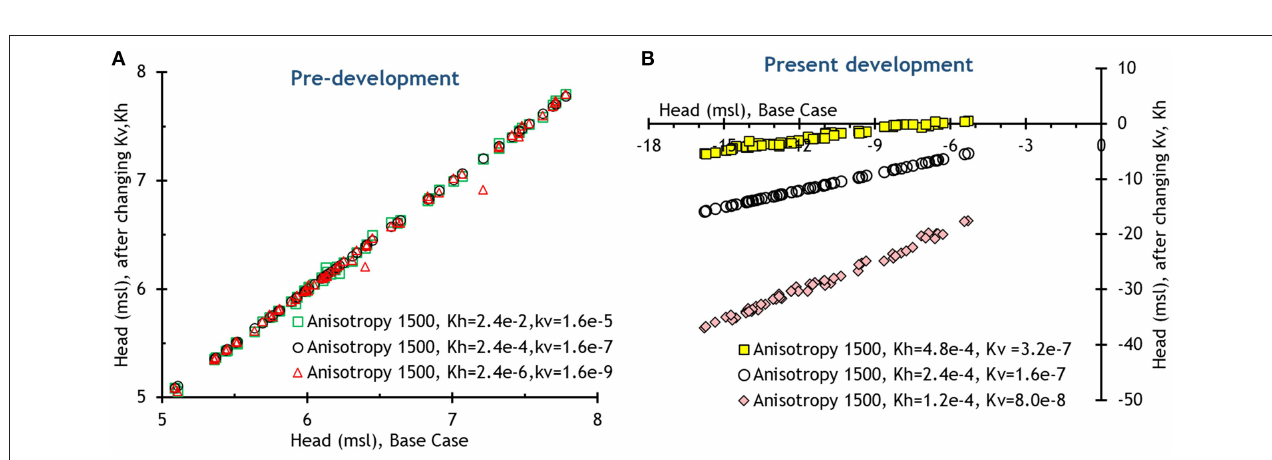
FIGURE 5 | The change of the heads of GWLMS with the change of K h and K v values under (A) predevelopment and (B) present development conditions.